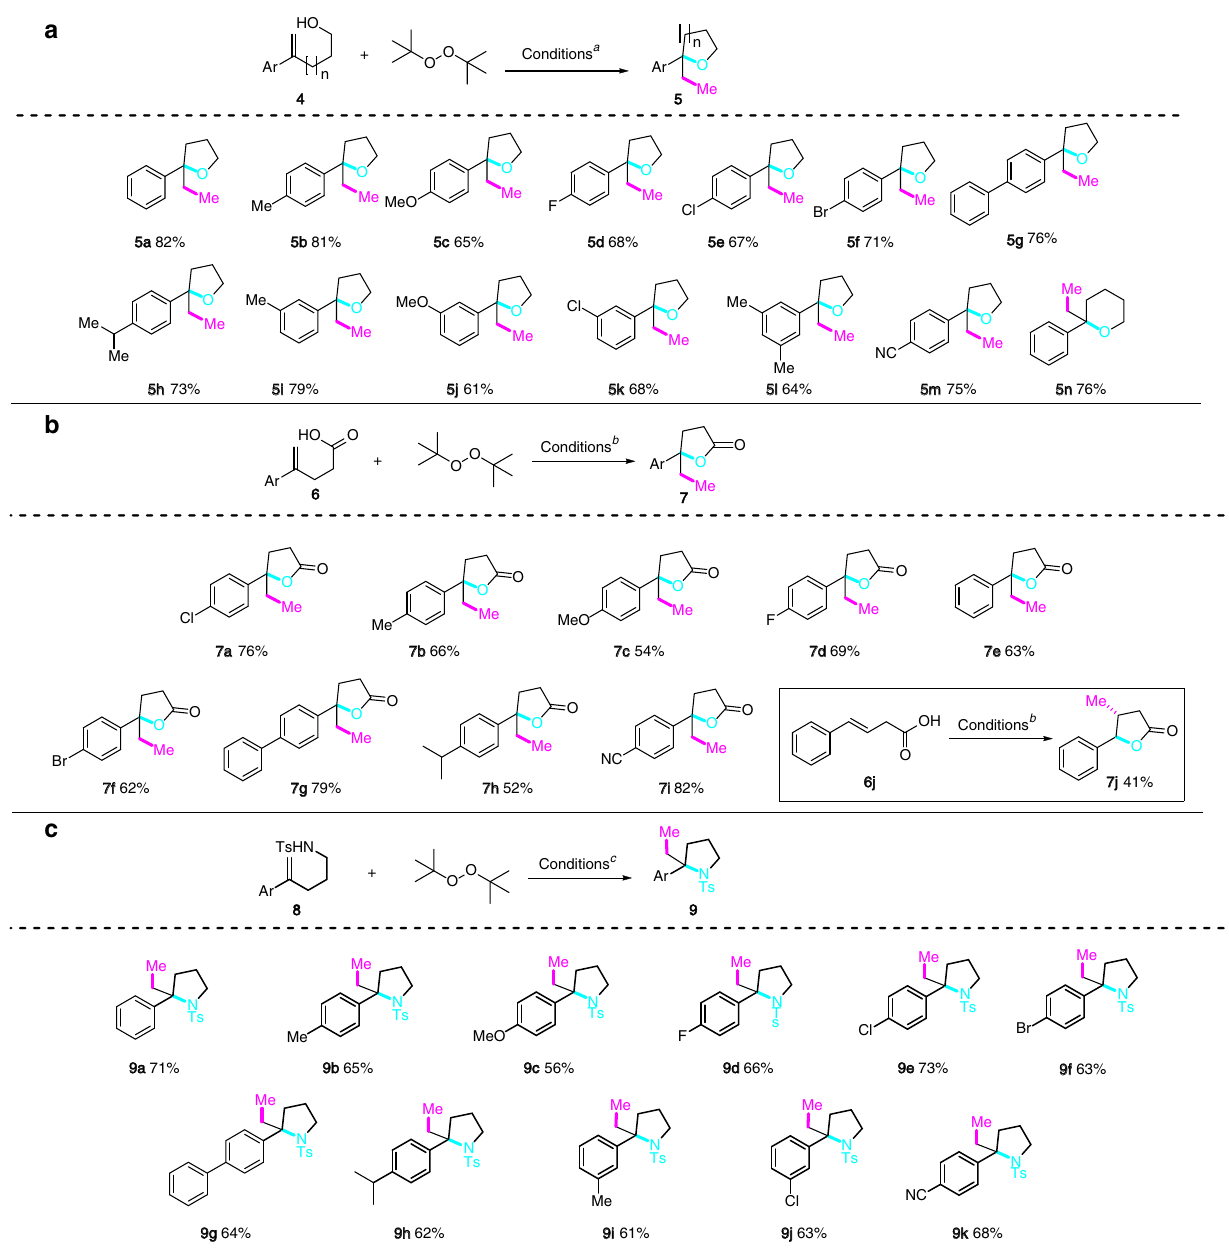
Fig. 4 Methylative heterocyclization of alkenes. a Methylative cycloetheri fi cation: 4 (0.2 mmol), Cu(OTf) 2 (0.2 equiv), L1 (0.3 equiv), Na 3 PO 4 (0.2 equiv), DTBP (4.0 equiv), CF 3 CH 2 OH ( c 0.1 M), 120 °C. Yields refer to isolated products. b Methylative lactonization: 6 (0.2 mmol), CuSO 4 (0.2 equiv), L2 (0.3 equiv), Na 3 PO 4 (0.3 equiv), DTBP (4.0 equiv), t BuOH ( c 0.1 M), 120 °C. c Methylative cycloamination: 8 , Cu(OAc) 2 (0.2 equiv), L2 (0.3 equiv), Na 3 PO 4 (0.2 equiv), DTBP (4.0 equiv), t BuOH ( c 0.1 M), 120 °C